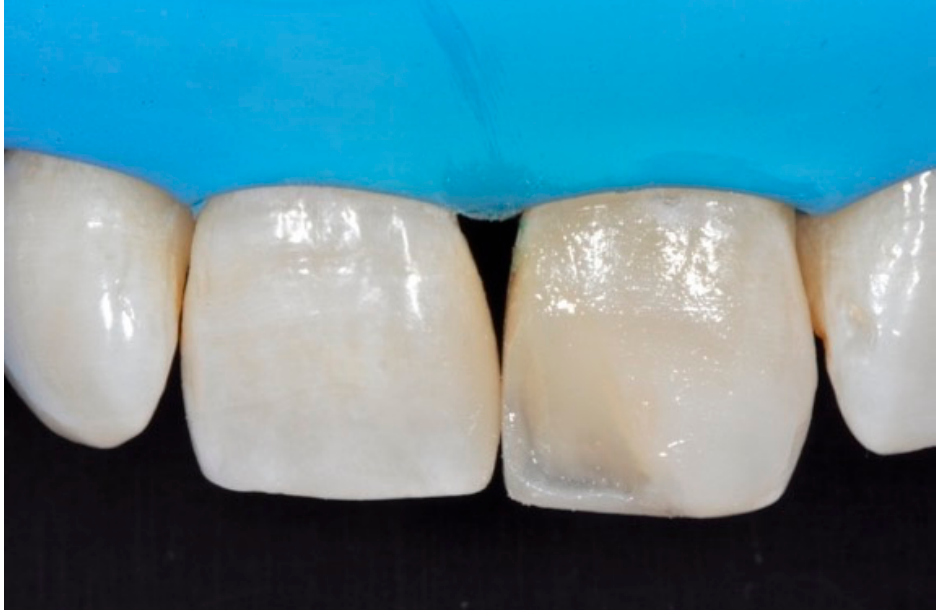
Figure 45. Dentinal body with space left for translucencies.